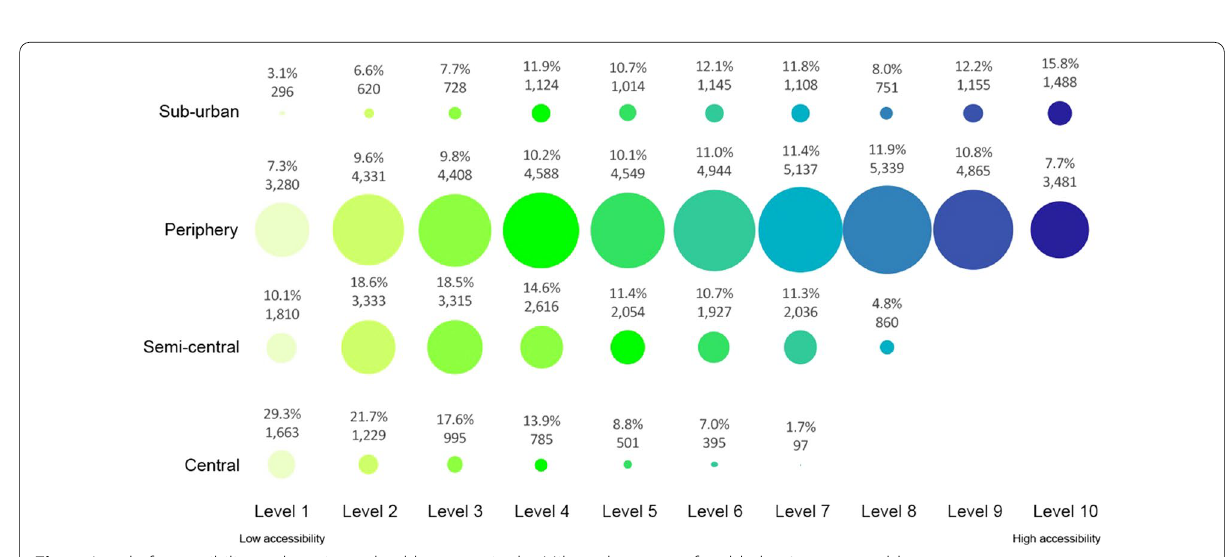
Fig. 7 Level of accessibility at the primary health centres in the Milan urban zones for elderly 70–74 years